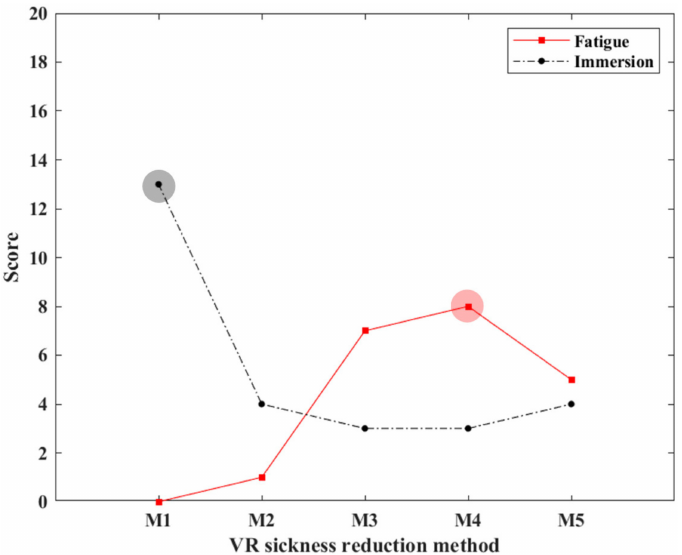
Figure 9. Comparing fatigue and immersion scores of VR sickness reduction